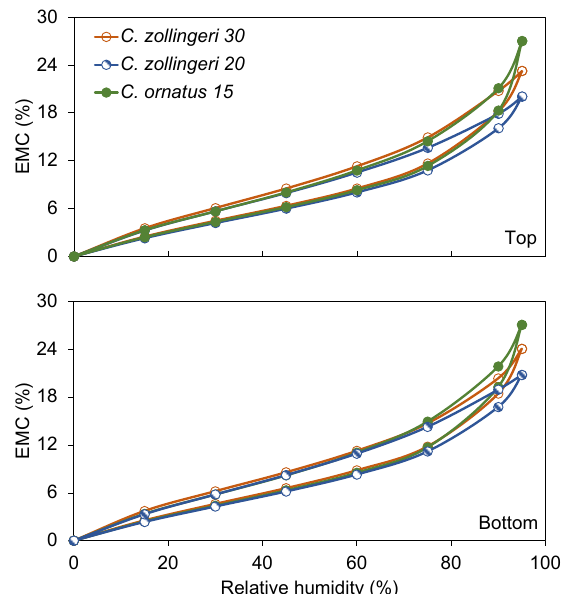
Figure 3. Equilibrium moisture content (EMC) of bottom/mature and top/juvenile rattan samples of different diameter classes (30, 20, and 15 mm) during the adsorption and desorption runs. The EMC of rattan samples increased with increasing RH from 0 to 95%. Identical EMC values were observed in the top and bottom samples within the same species. There were no differences in the EMC values of the samples at RHs below 60% during both adsorption and desorption runs. The moisture adsorption isotherms are similar to the one reported by Yang et al. [36]. The highest EMC value was obtained at 95% RH for sample C. ornatus , which was ca. 27%. The sharp upward bend above 70% RH is generally accepted to be related to the softening point of hemicelluloses [40]. Removal of the lignin increased